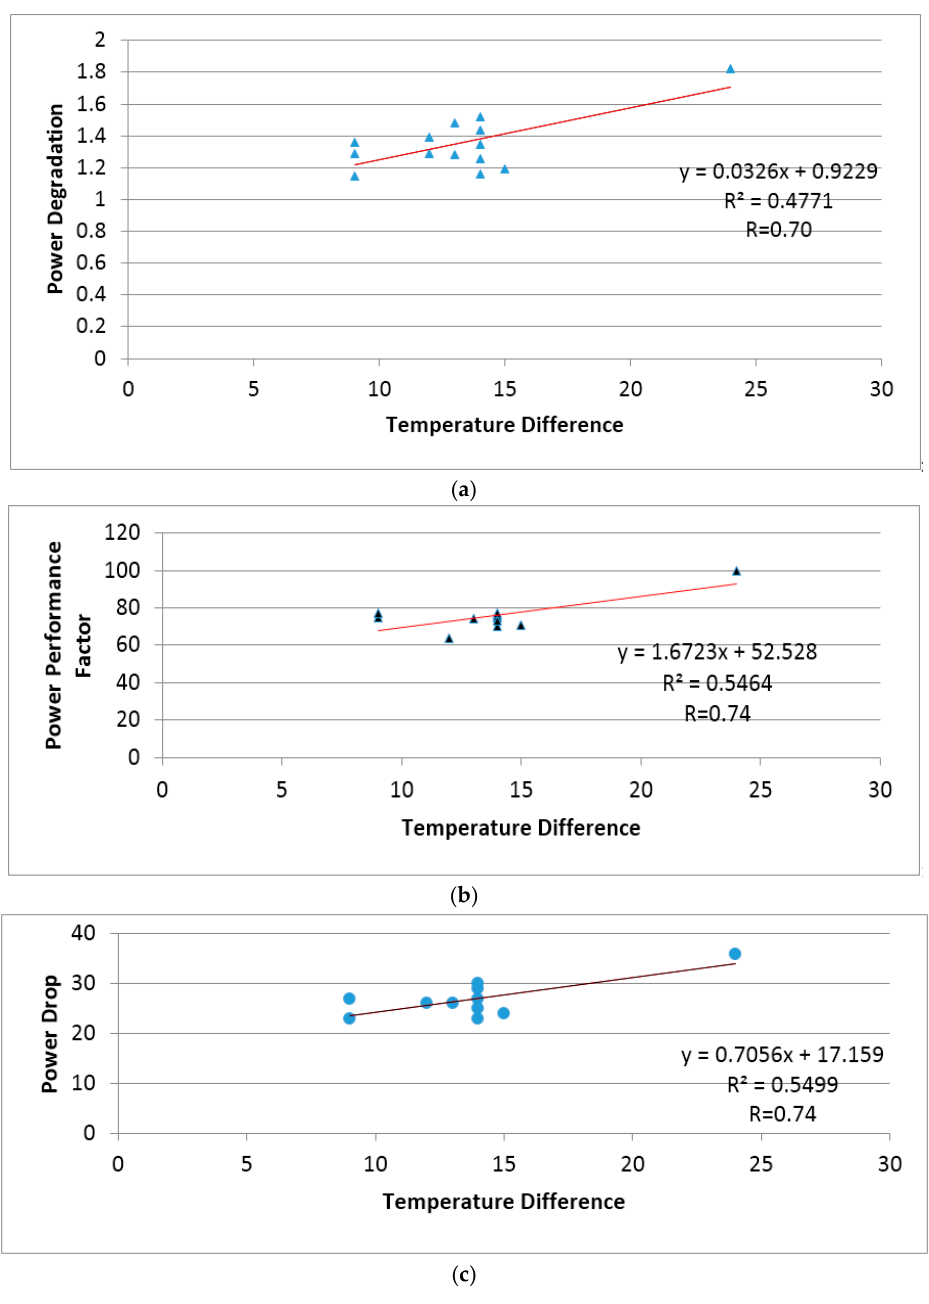
Figure 11. Graphs of temperature difference vs. P deg , PPF and P drop . ( a ) Temperature difference vs. P deg ; ( b ) temperature difference vs. PPF; ( c ) temperature difference vs. P drop .